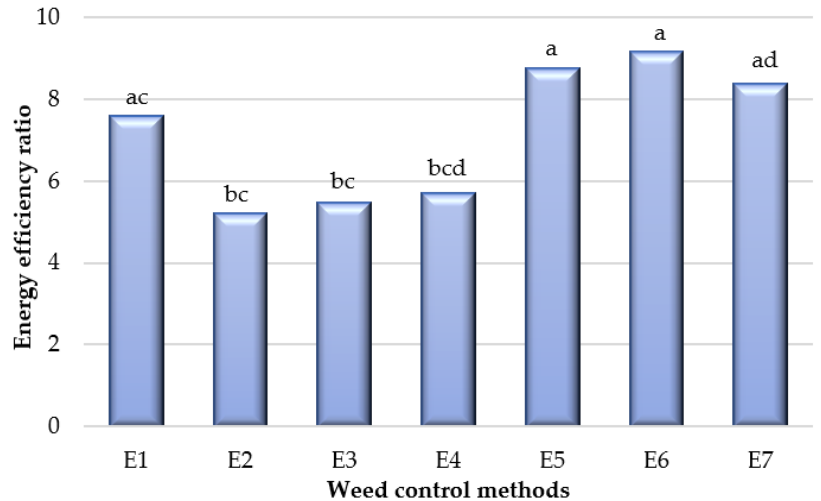
Figure 5. The impact of weed control methods on energy efficiency ratio.